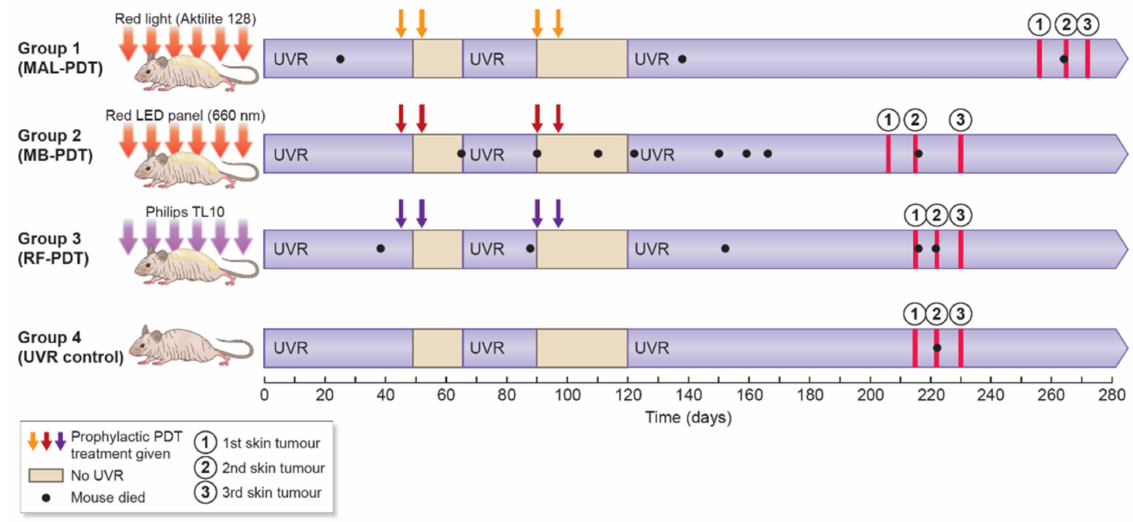
Figure 1. Study overview. Abbreviations: MAL, methyl aminolevulinate; MB, methylene blue; RF, riboflavin; PDT, photodynamic therapy; LED, light-emitting diode; UVR, ultraviolet